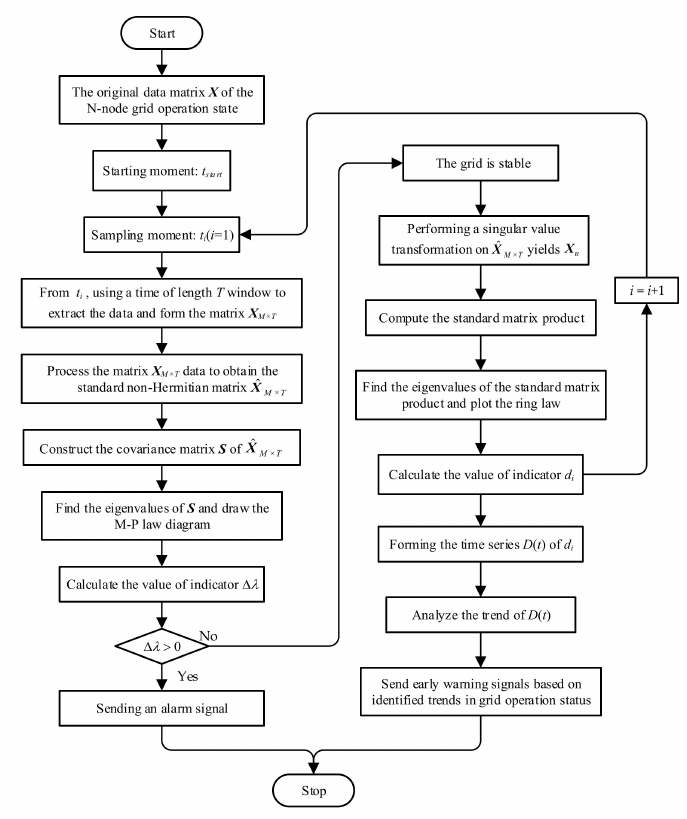
Figure 4. Flowchart of real-time grid condition assessment